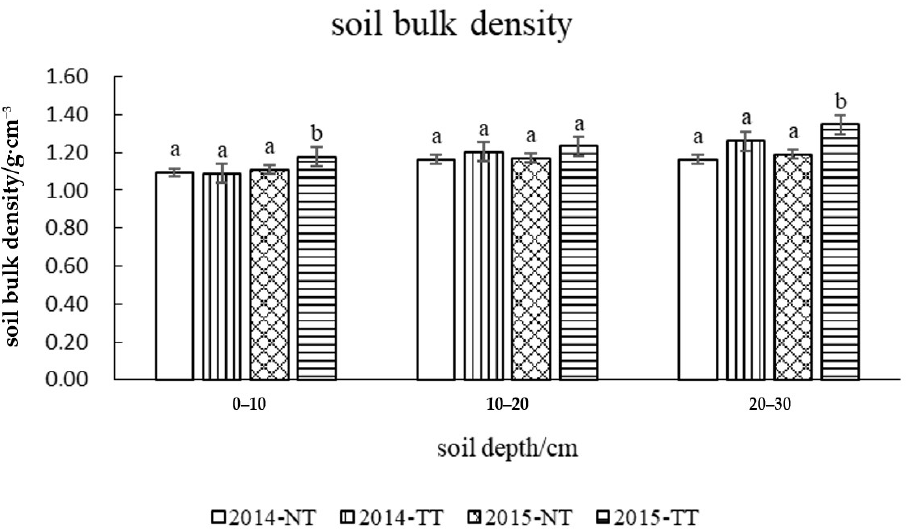
Figure 2. Mean bulk density of NT and TT treatments in 0–10 cm, 10–20 and 20–30 cm depths in 2014 and 2015. Samples were taken immediately after maize harvest in October every year. Means within each depth followed by the same letter were not significantly different ( p > 0.05); NT: no tillage with straw cover; TT: traditional tillage with conventional ploughing.